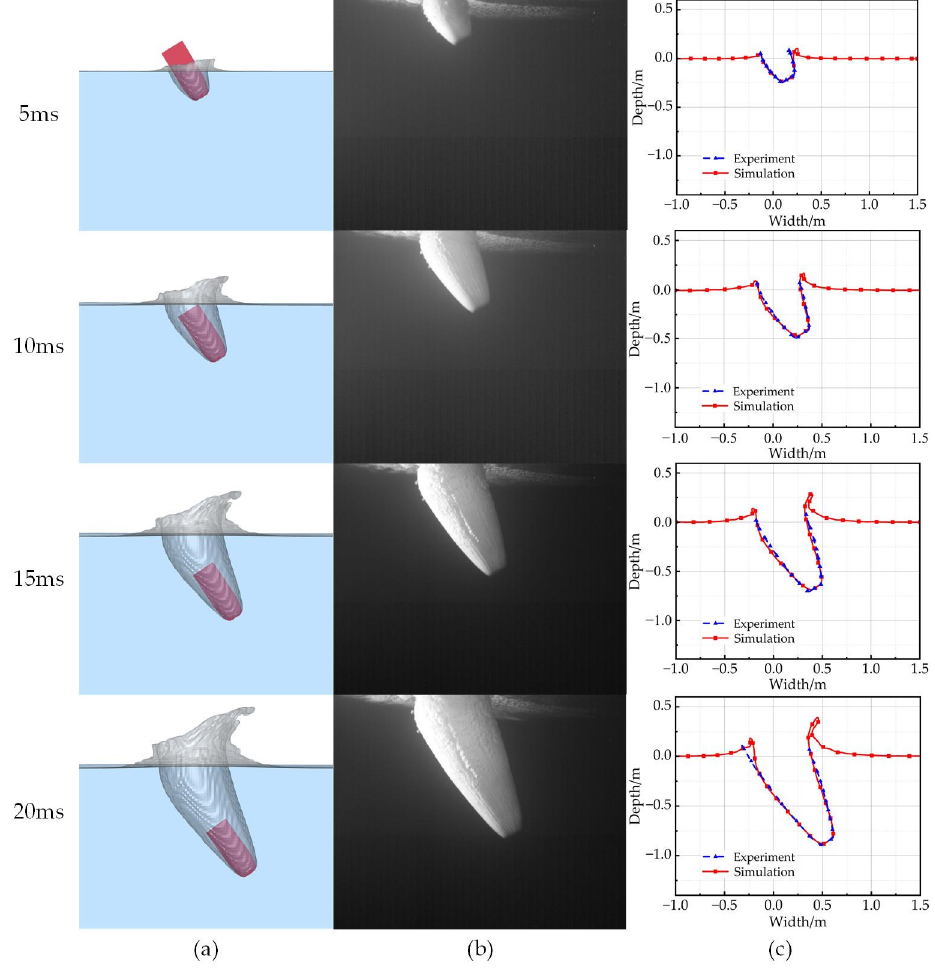
Figure 5. Cavitation comparison between simulation and experiment: ( a ) simulation, ( b ) experiment, ( c ) comparison.